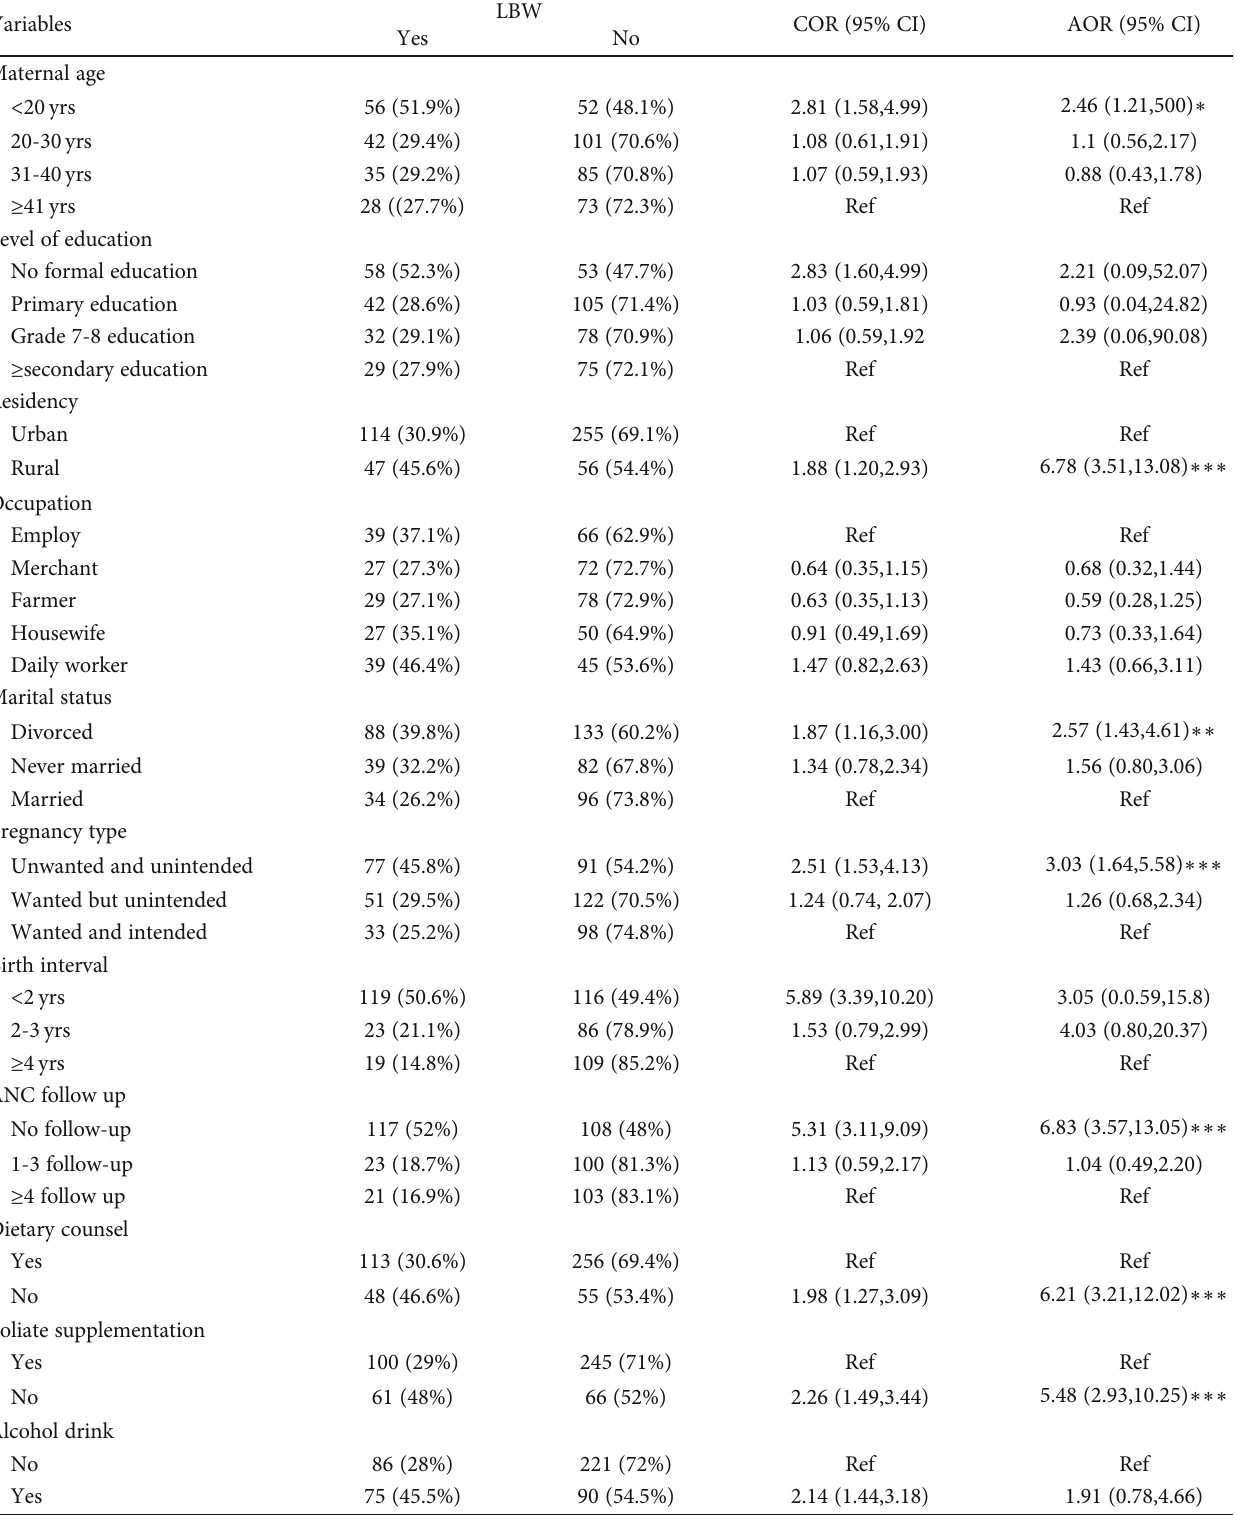
Table 3: Bivariate and multivariate logistic regression analysis of factors associated with low birth weight neonates, Dilla town, Southern